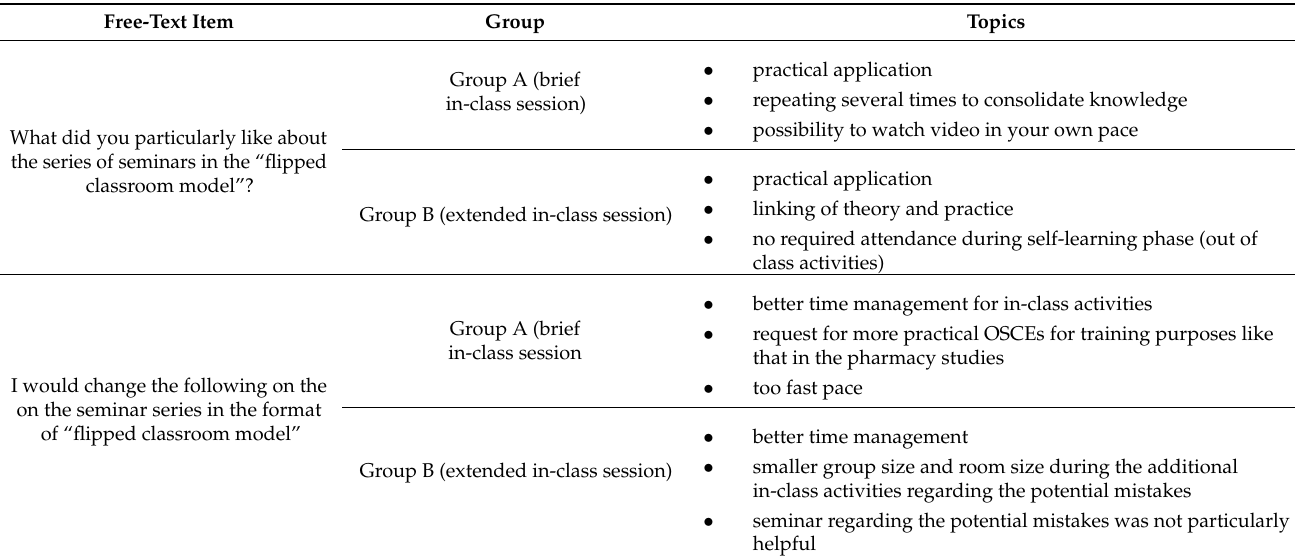
Table 4. Exemplary topics of comments on free-text questions/items of the perception and satisfaction survey. Free-Text Item Group